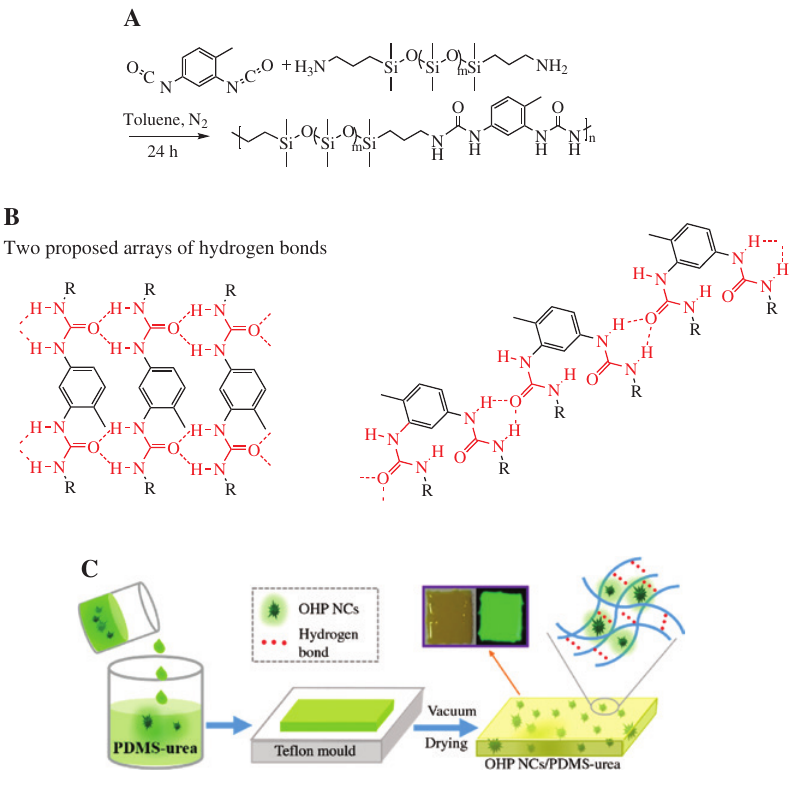
Scheme 1: (A) Synthesis of the PDMS-urea copolymer; (B) Proposed arrays of hydrogen bonding of the PDMS-urea copolymer and (C) Schematic illustration of the preparation and structure of the OHP NC/PDMS-urea